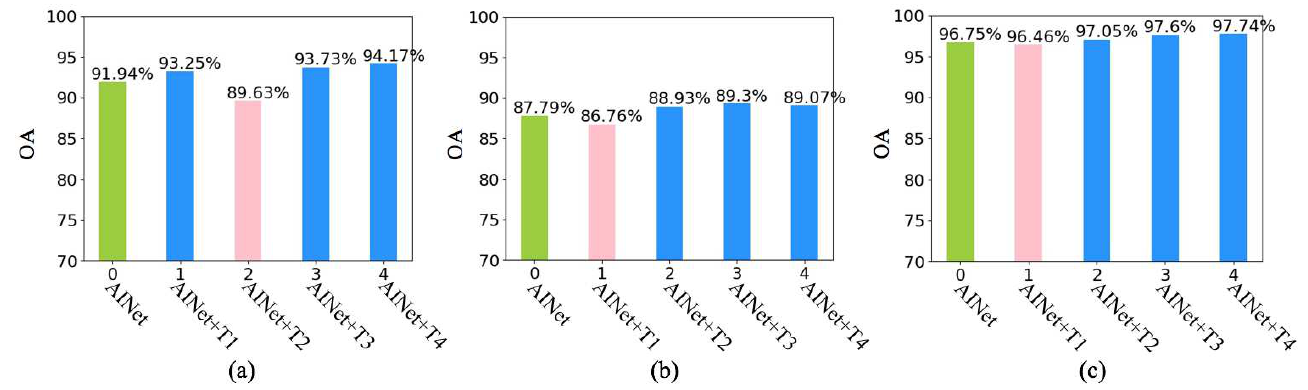
Figure 10. Transfer learning experiments with 30 training samples per class. ( a ) Pavia University; ( b ) Indian Pines; ( c ) Kennedy Space Center.